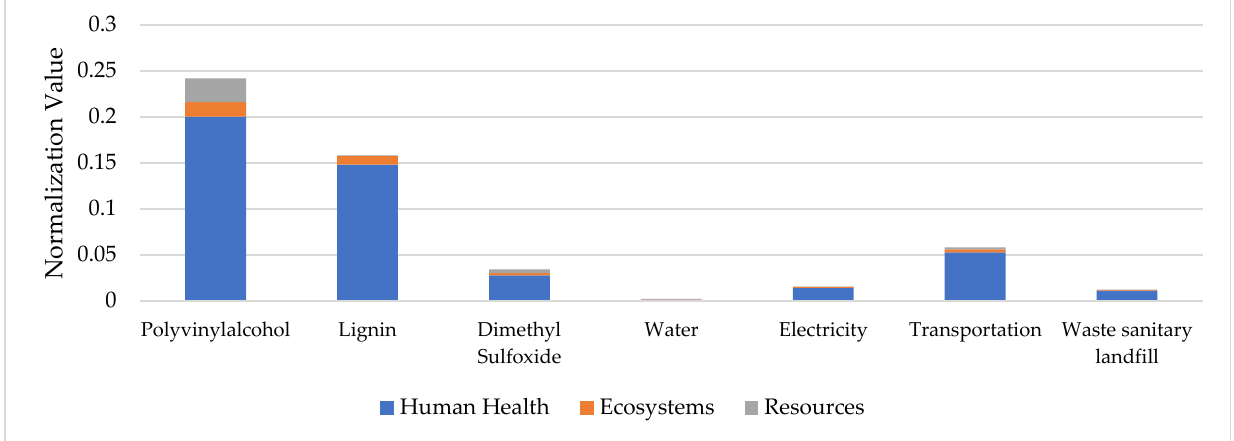
Figure 12. Endpoint impact categories of mulch film PVA with lignin (40PVA/60LN) based on the ReCipe Endpoint (H) method.